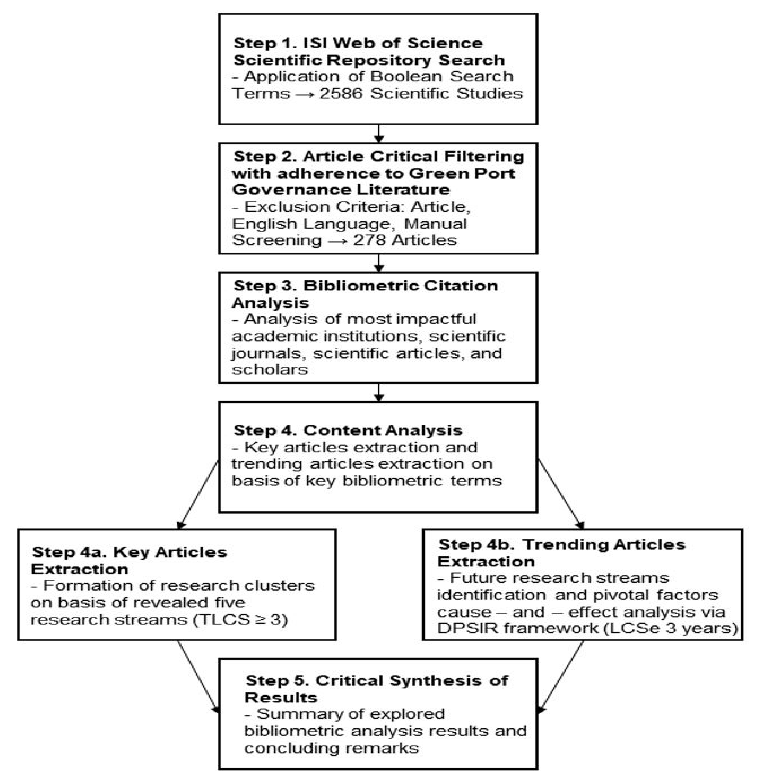
Figure 1. Bibliometric analysis five-step methodological workflow.